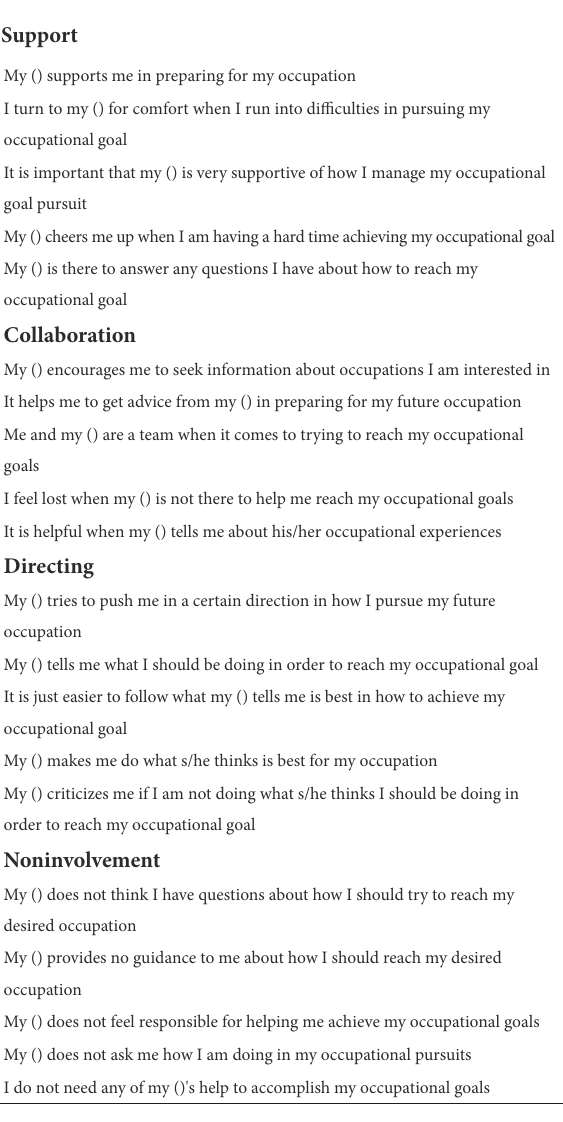
TABLE 1 Occupational shared agency scale item